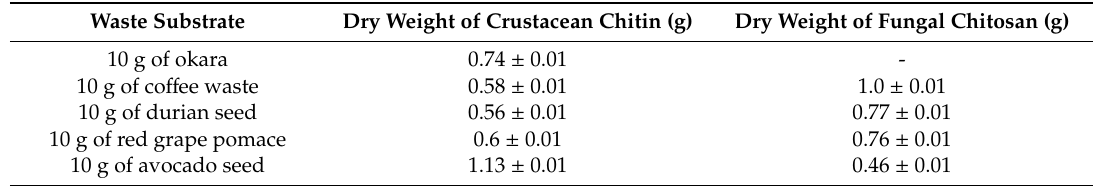
Table 1. Dry weights of crustacean chitin and fungal chitosan extracted after fermentation on various waste